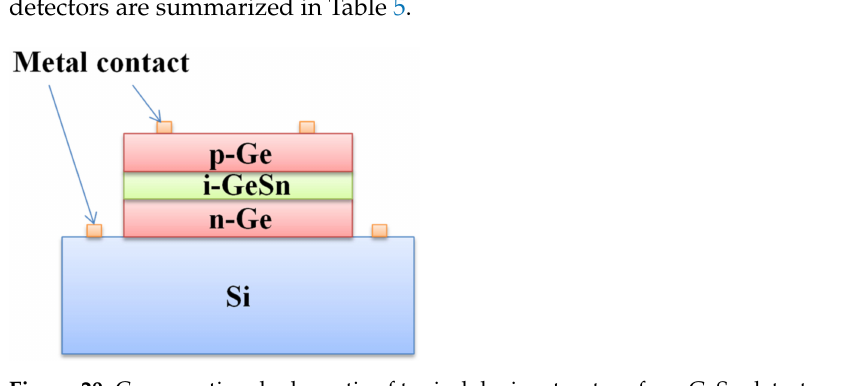
Figure 20. Cross-sectional schematic of typical device structure for a GeSn detector. Table 5. Summary of reported GeSn PIN detectors in terms of Sn content, GeSn thickness, device structure, wavelength cutoff, and responsivity.